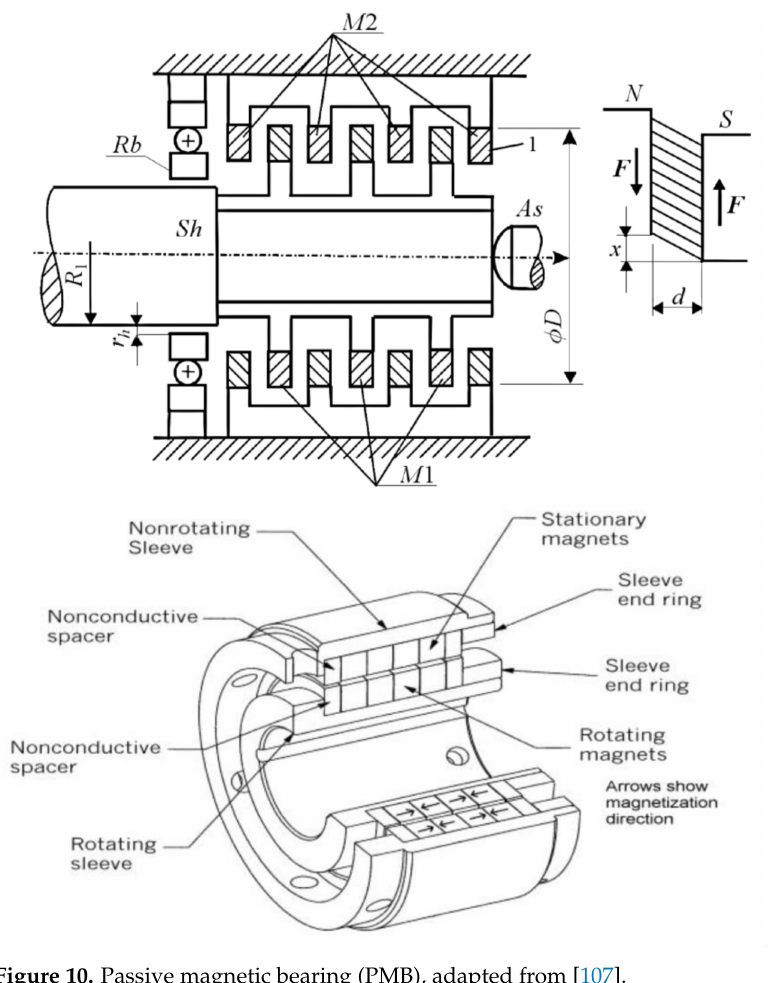
Figure 10. Passive magnetic bearing (PMB), adapted from